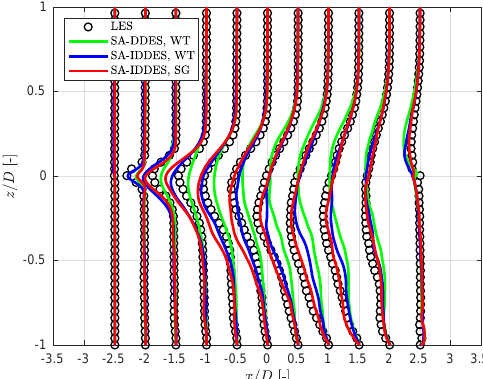
Figure 10. Time-averaged resolved shear stress < u (cid:48) w (cid:48) > . WT and SM denote the wind tunnel model and simplified geometry, respectively.